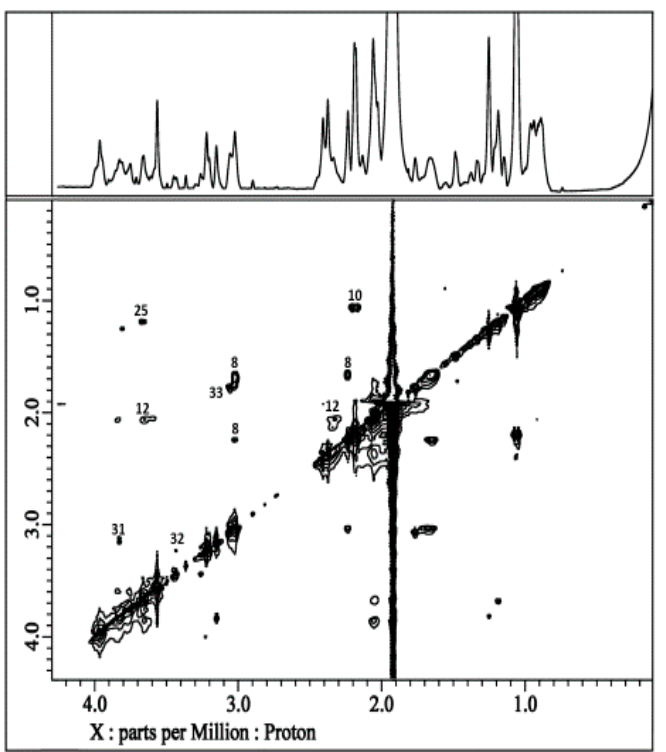
Figure 6. ( a , b ) Partial 600 MHz 1 H- 1 H TOCSY NMR spectra of WMS supernatant samples. Typical spectra are shown. The spectrum shown in ( a ) is adapted and updated from that available in [3] with permission. This spectrum was acquired on a Bruker AMX-600 spectrometer, and acquisition parameters for it are also provided in [3]. Connected resonance assignments: 1, fatty acids (terminal- CH 3 spin system); 2, leucine; 3, fatty acids (bulk acyl chain spin system, including α -CH 2 resonance); 4, lysine; 5, 2-hydroxyglutarate; 6, γ -aminobutyrate; 7, ornithine; 8, 5-aminovalerate; 9,